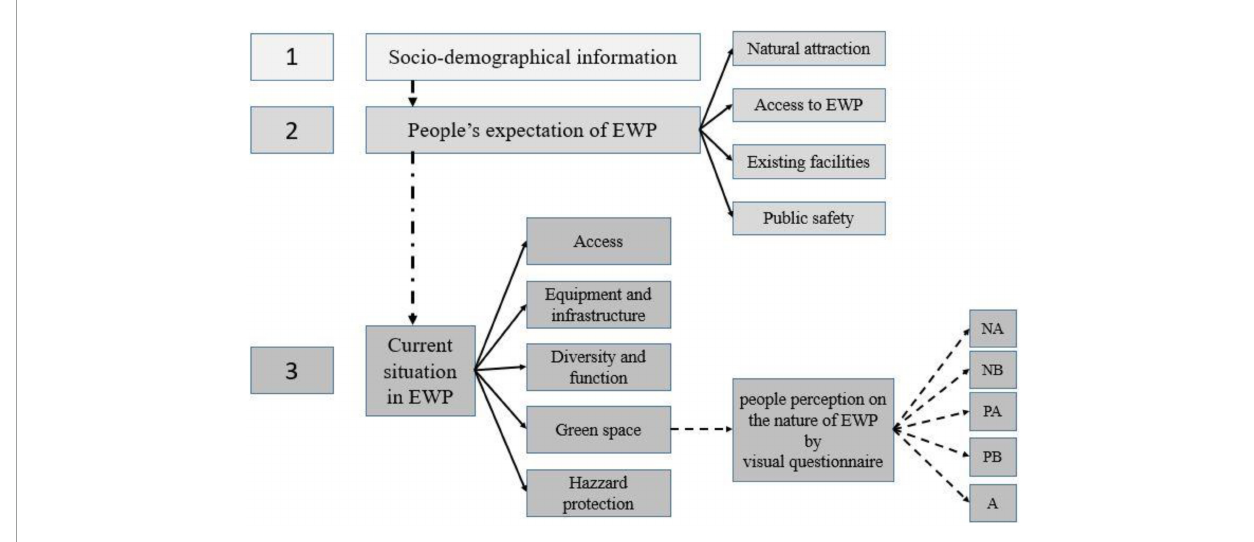
FIGURE2 Conceptual framework in obtaining data of the